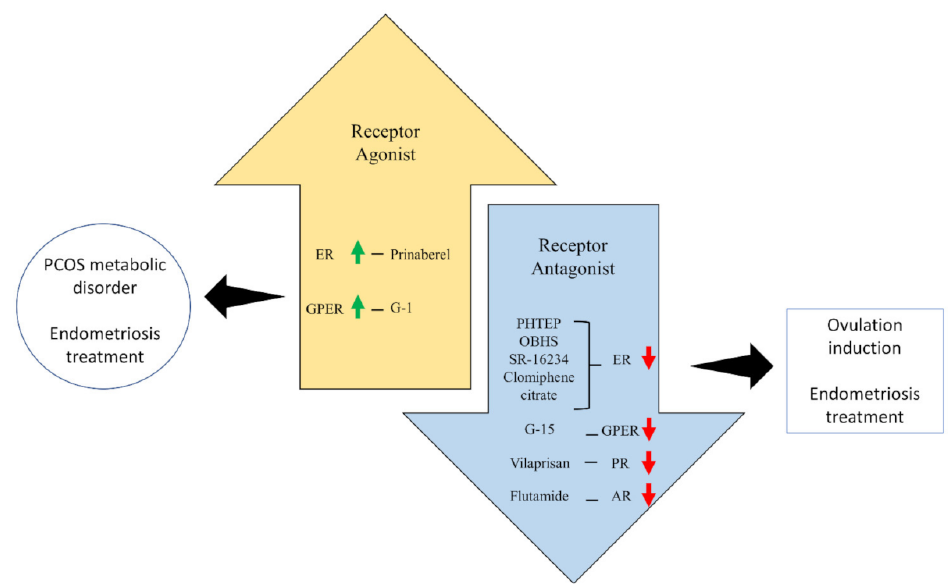
Figure 3. Summary of potential treatment routes for PCOS-related disorders. ER: oestrogen receptor; PR: progesterone receptor; AR: androgen receptor; GPER: G-protein oestrogen receptor; OBHS: oxabicycloheptene